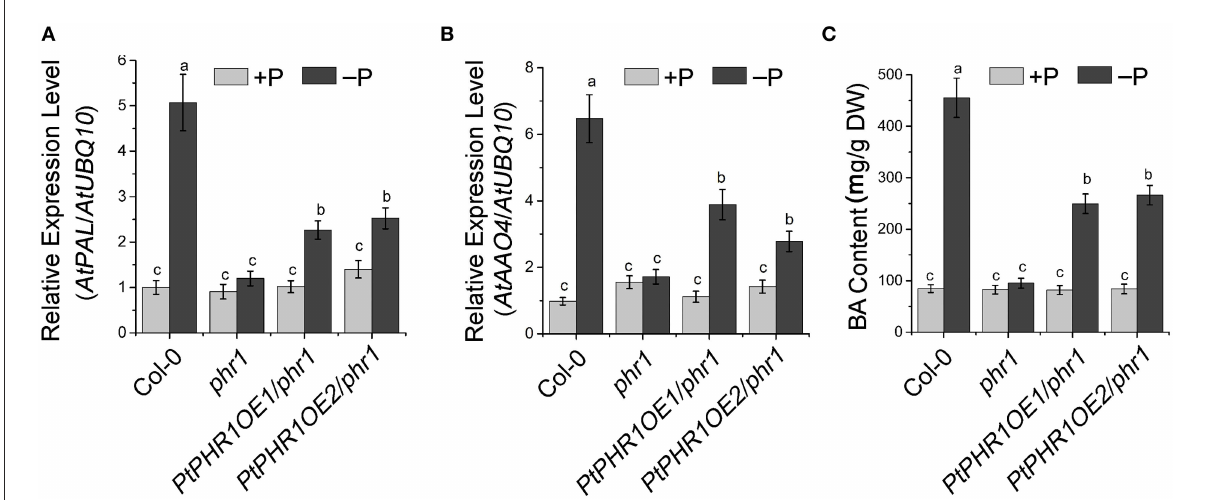
FIGURE6 PHR1 is involved in Pi starvation-induced BA biosynthesis. Expression level of AtPAL (A) and AtAAO4 (B) and BA content (C) in 9-day-old Col-0, phr1, and PtPHR1OE/phr1 seedlings grown in + P and –P conditions. The transcript levels were analyzed by qRT-PCR. Values are means ± SD of three biological replicates. Different letters indicate significant difference at P < 0.05 by Fisher’s least significant difference